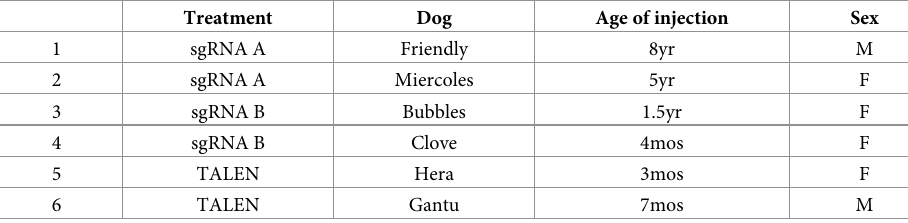
Table 1. Study design for HDR-treated dogs. Dogs were assessed 3 months after treatment.